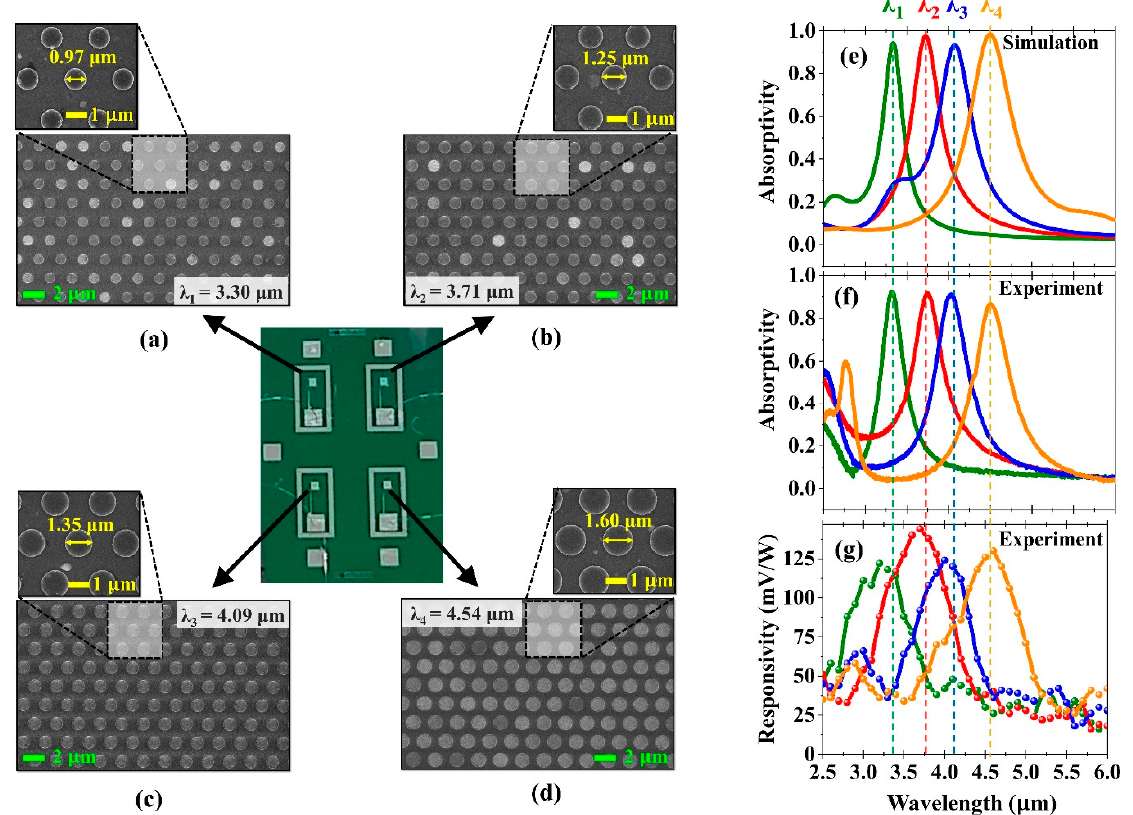
Figure 7. ( a – d ) Scanning electron microscope (SEM) images of the fabricated disk array patterns at four resonance wavelengths. ( e , f ) Simulated and measured absorptivities of the perfect absorbers at four resonance wavelengths. ( g ) Measured responsivity of the quad-wavelength detector.